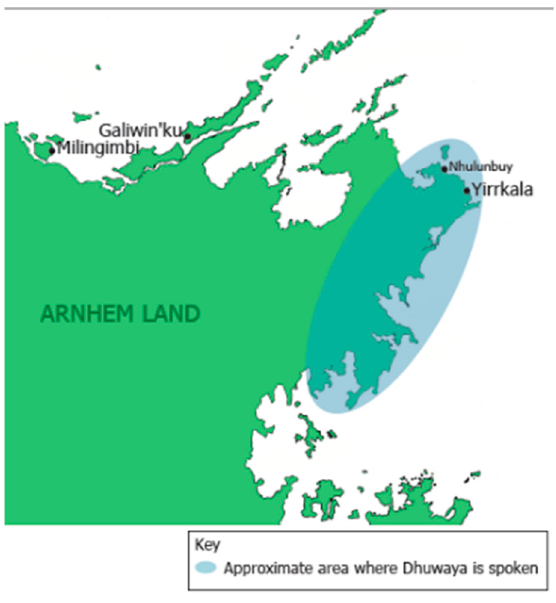
Figure 1. Dhuwaya